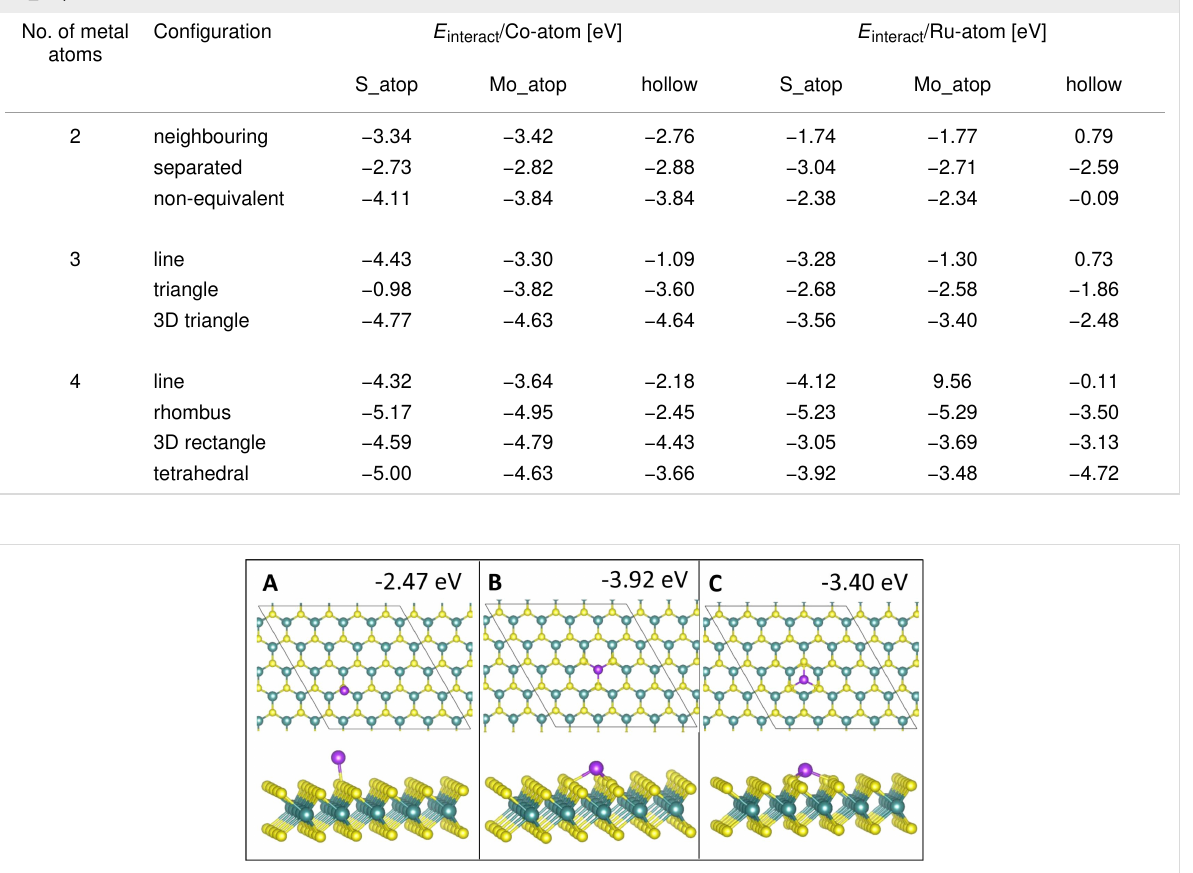
Table 3: Computed metal–metal interaction energies using Equation 3. For the “non-equivalent” configurations for two metal atom adsorption, the column “S_atop site” has atoms at sites S_atop and Mo_atop, “Mo_atop site” has atoms at S_atop and hollow, and “hollow site” has atoms at Mo_atop and hollow.